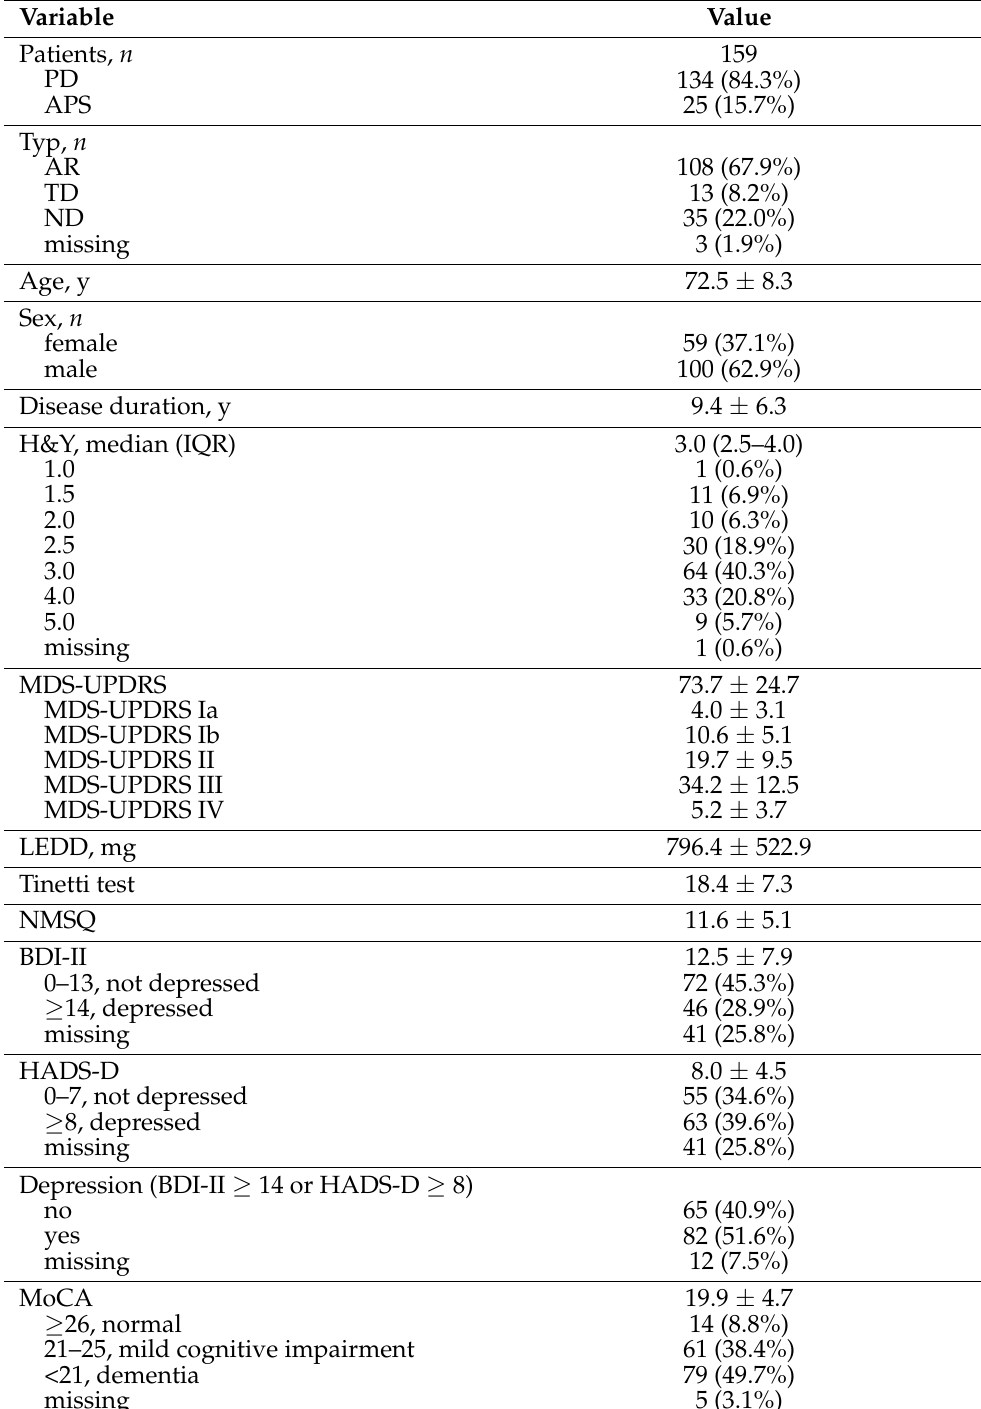
Table 1. Study population, baseline